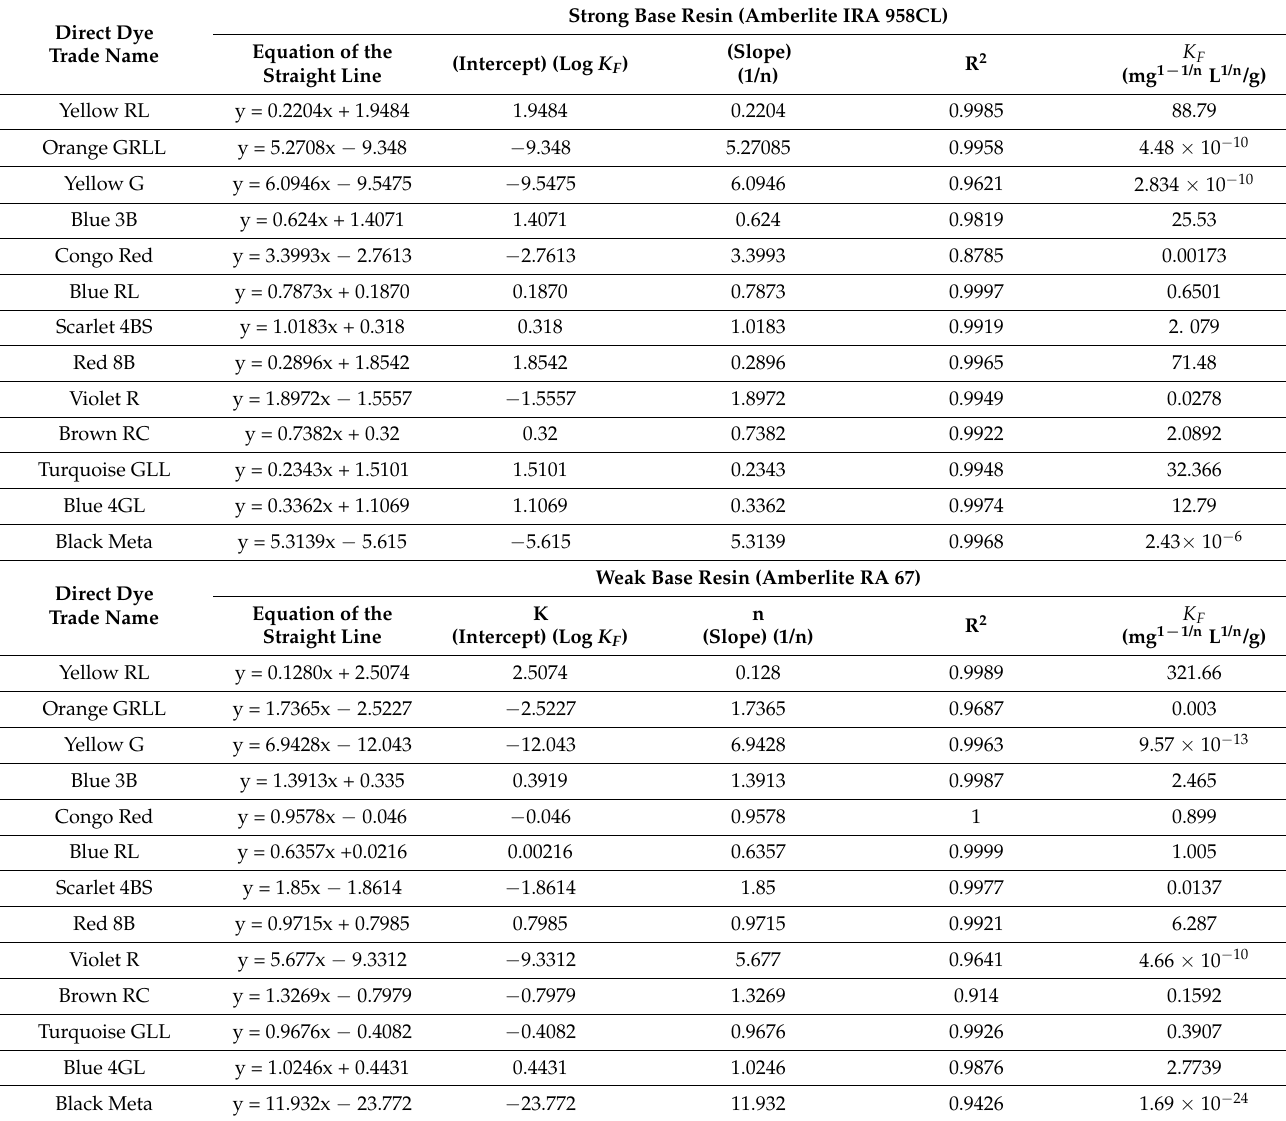
Table 6. Equations, values of slope, and intercept for Freundlich